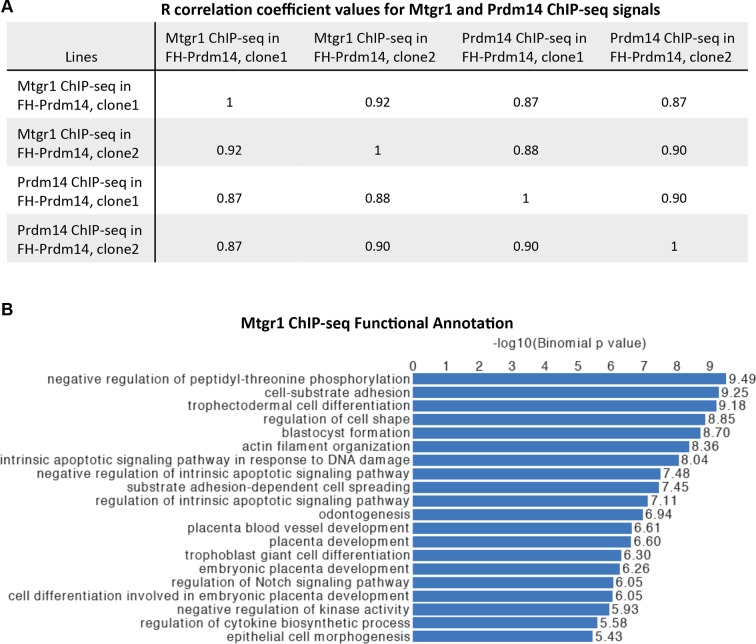
Genomic occupancy of Mtgr1.(A) Correlation coefficient, R, between Mtgr1 and Prdm14 (anti-HA) ChIP-seq genomic occupancy levels in two different clonal FH-Prdm14 mESC lines. (B) Functional annotation categories of the Mtgr1 binding sites in FH-Prdm14 mESCs as determined by GREAT. ChIP-seq, chromatin immunoprecipitation with sequencing; GREAT, genomic regions enrichment of annotations tool; mESCs, mouse embryonic stem cell; Mtgr1, myeloid translocation gene related 1.